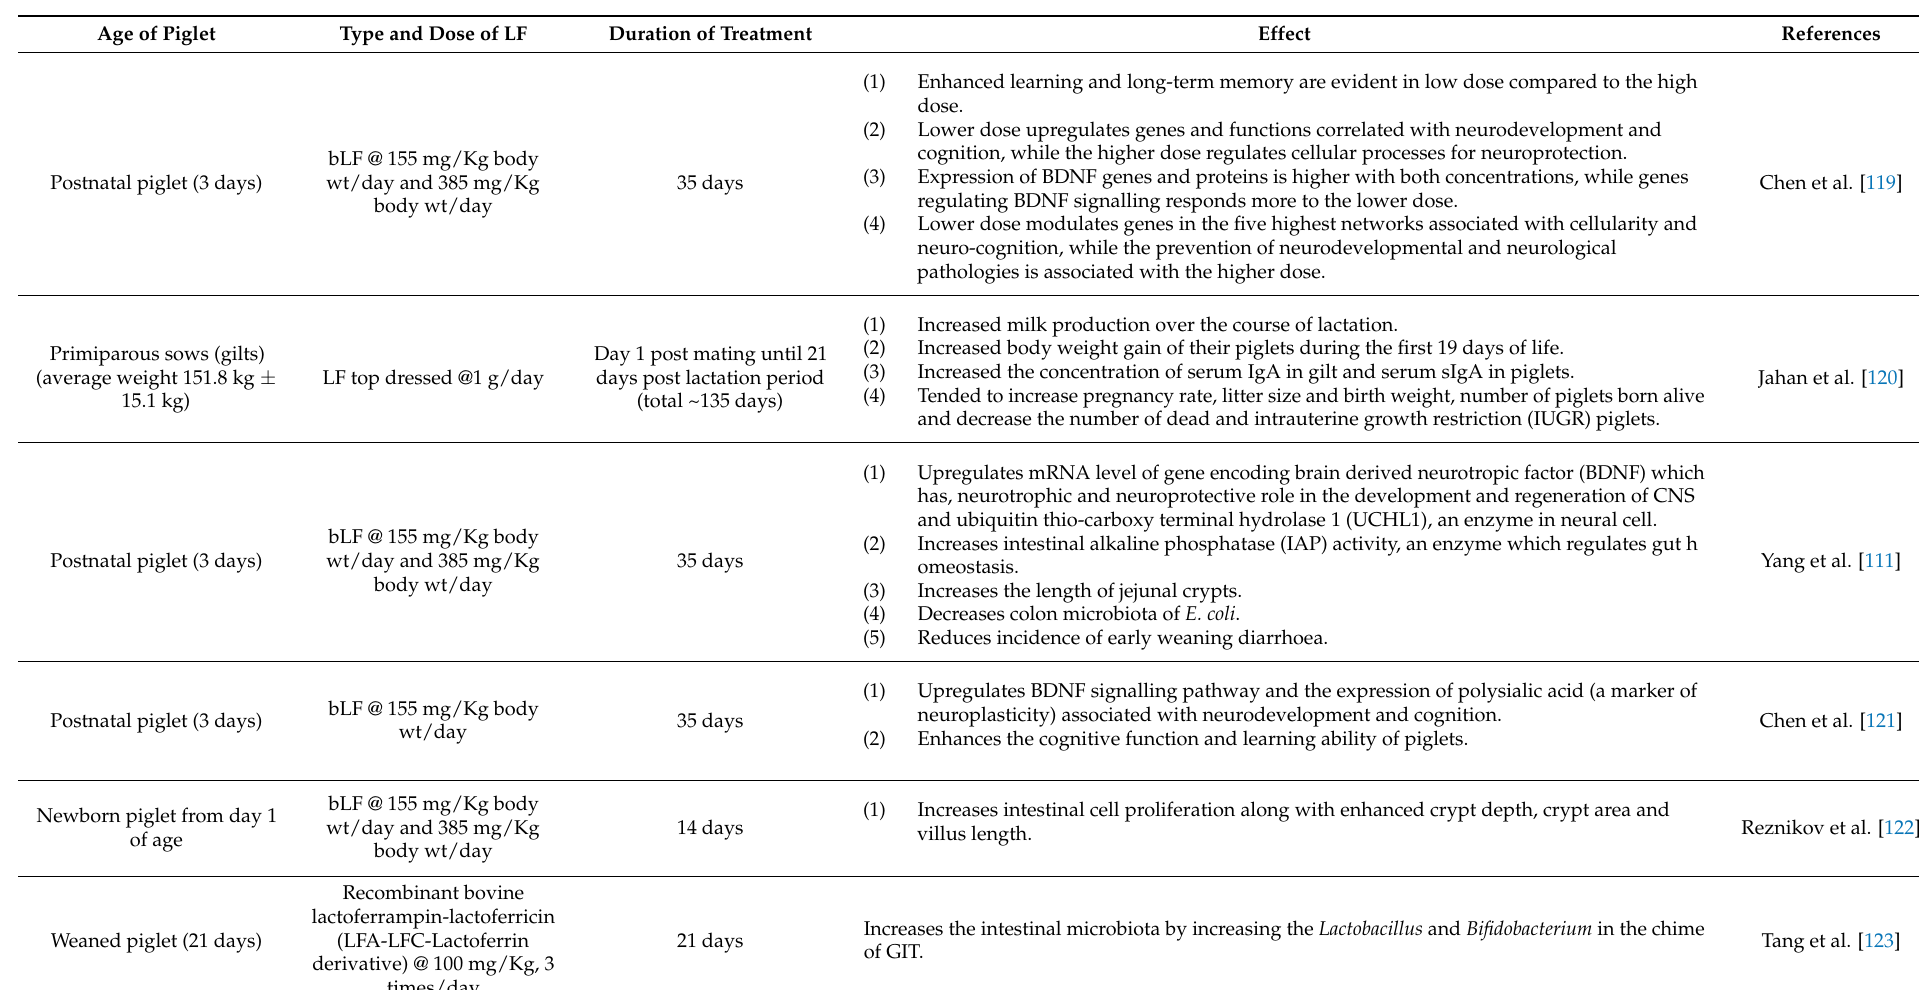
Table 3. A summary of key studies on the effects of oral supplementation of LF in